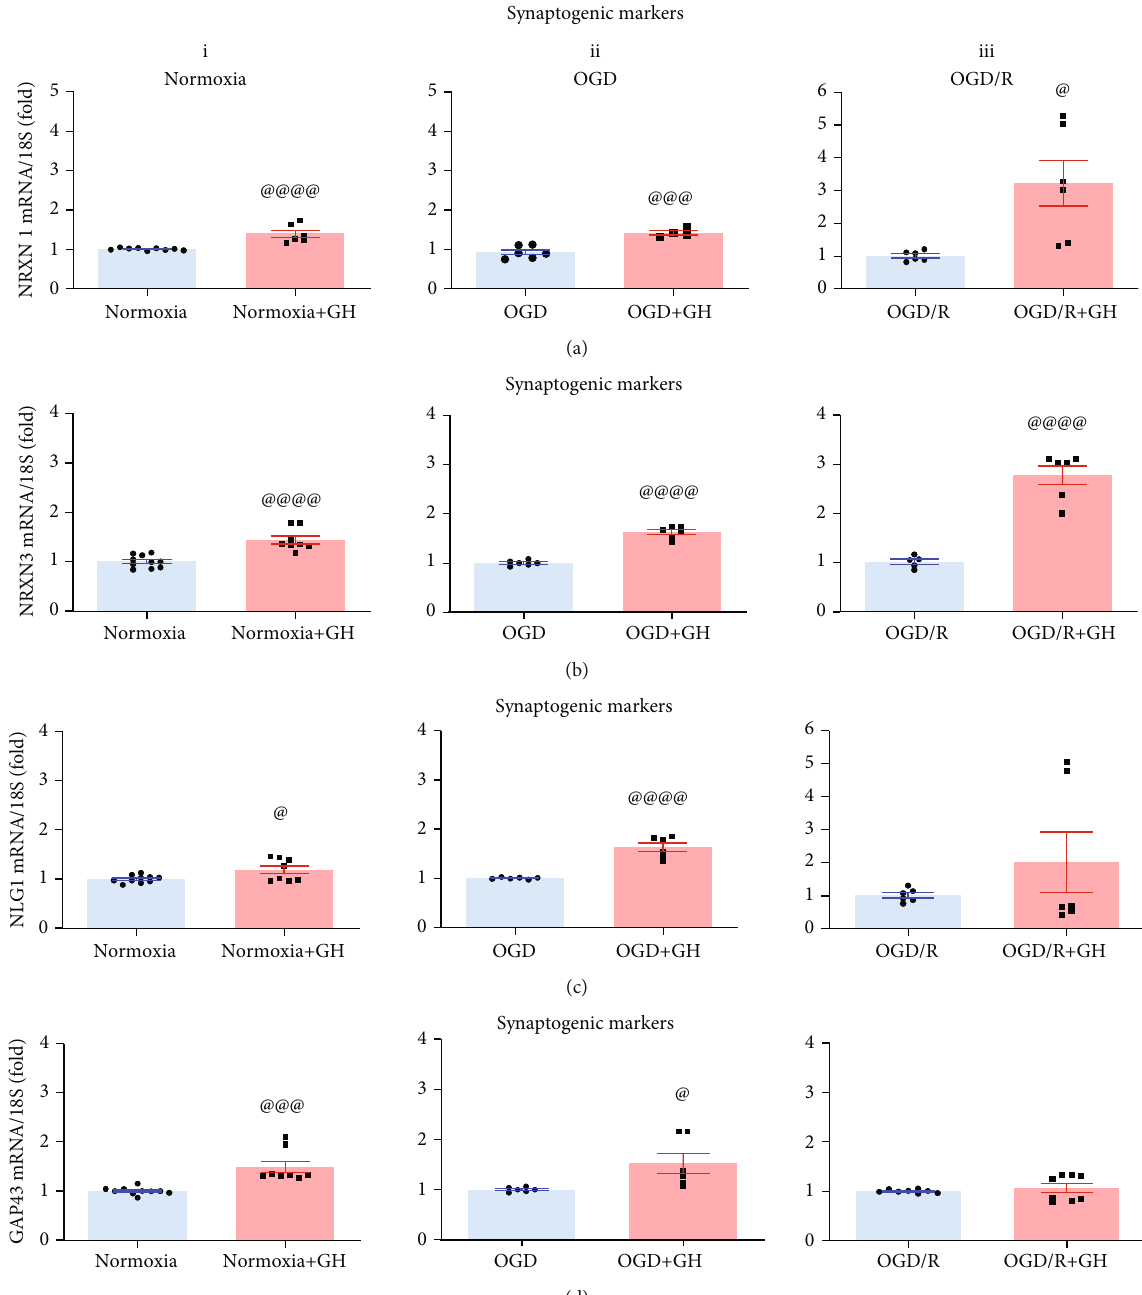
Figure 8: Growth hormone (GH) increases the expression of synaptogenic marker mRNAs in hippocampal cultures exposed to OGD and reoxygenation (OGD/R) conditions. Panels show the relative expression of (a) NRXN 1, (b) NRXN 3, (c) NLG1, and (d) GAP43 mRNAs, in each group: (i) normoxia, (ii) OGD, and (ii) OGD/R, as determined by RT-qPCR. Relative mRNA expression values were corrected by the comparative threshold cycle (Ct) method and employing the formula 2 − ΔΔ CT . Ribosomal 18S RNA was used as housekeeping gene. Bars represent mean ± SEM . The at sign (@) indicates signi fi cant di ff erences in comparison to control (@ p < 0 : 05 ; @@@ p < 0 : 001 ; @@@@, p < 0 : 0001 ) assessed by unpaired Student ’ s t